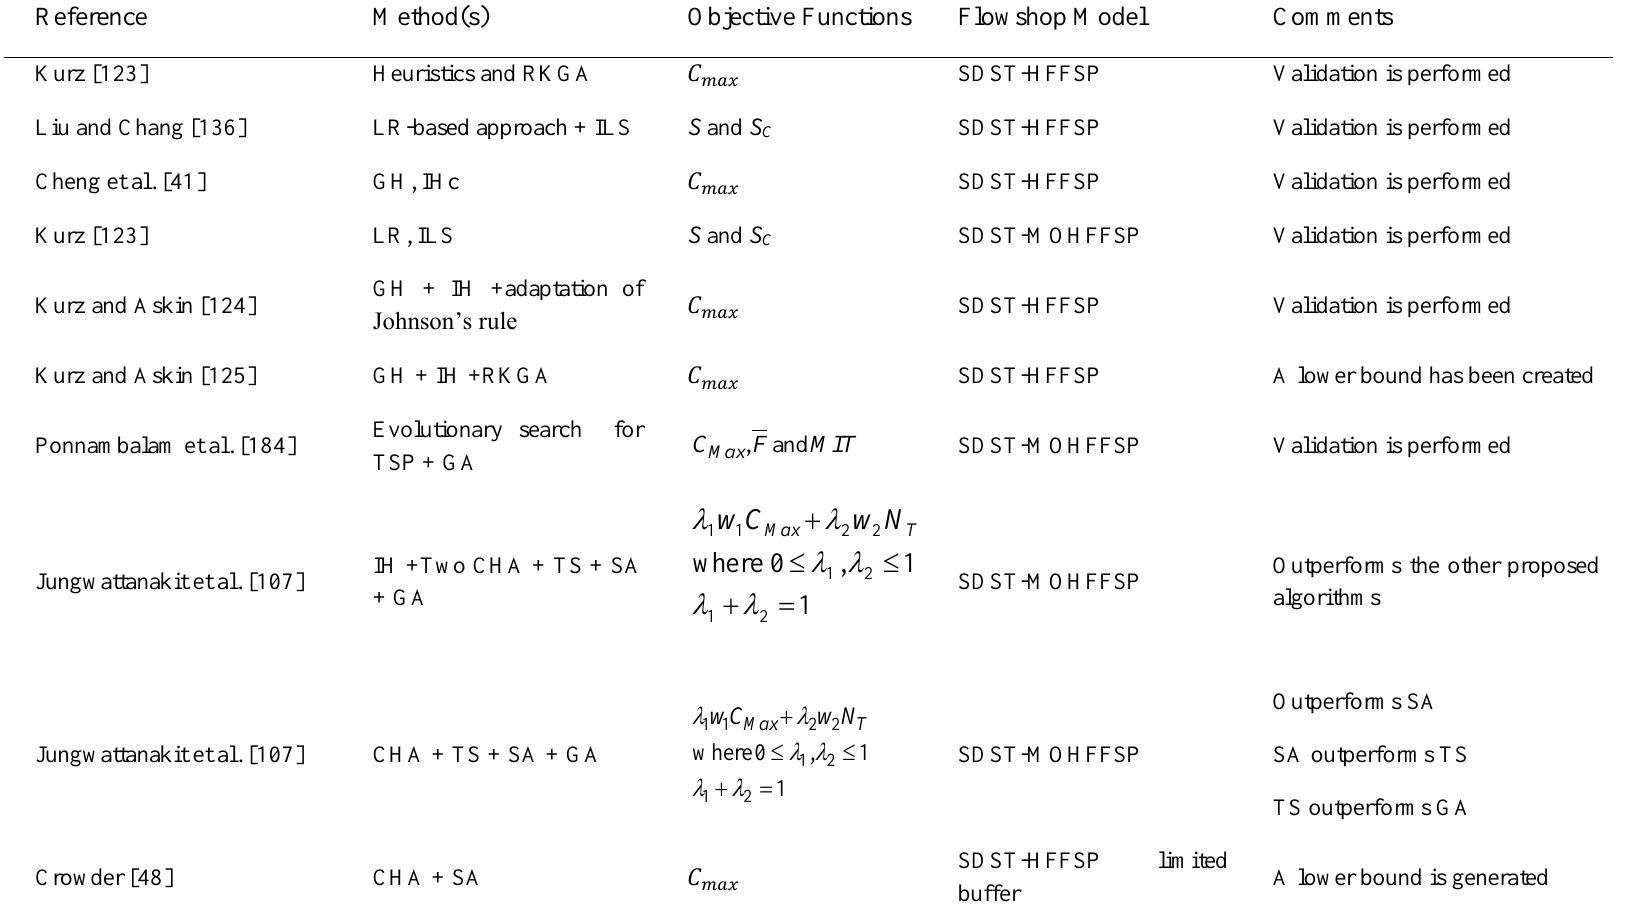
Table 4. A Consolidated Review of Flexible